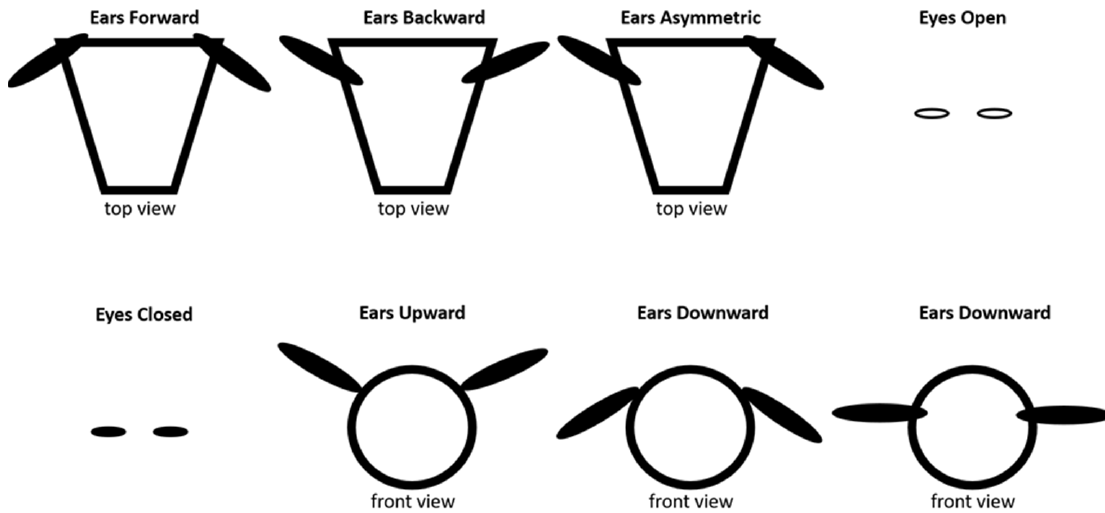
Figure 1. Mapping the emotions from facial features of cows and pigs. Facial feature classes and subclasses indicating potential affective states of cows and pigs.